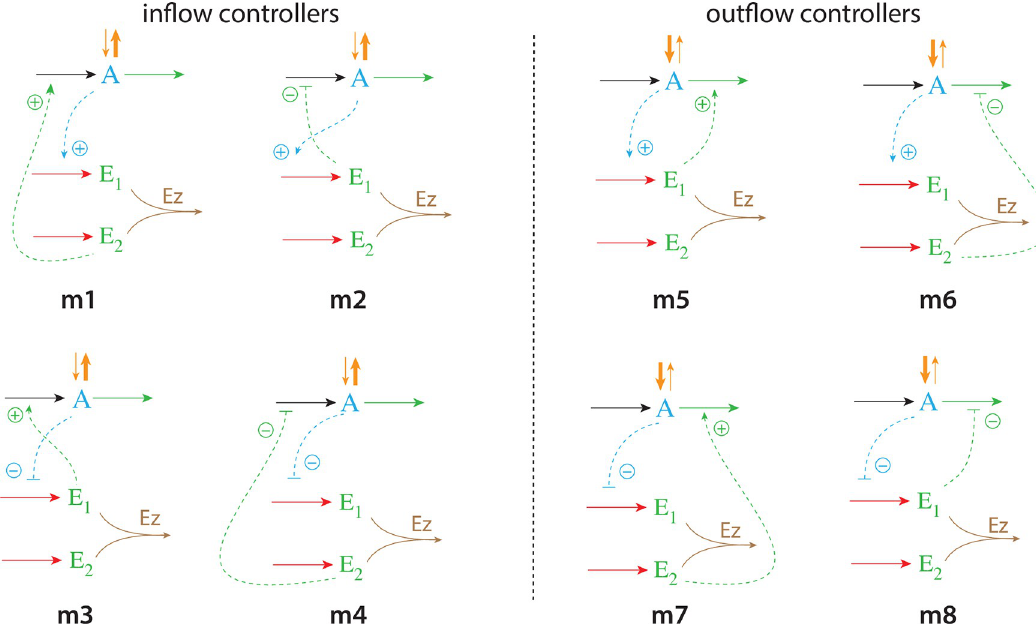
Fig 3. Dual-E (antithetic) integral control in combination with the eight negative feedback structures m1-m8. In the calculations the removal of E 1 and E 2 is catalyzed by enzyme Ez using different mechanisms. The signaling between A and the manipulated variables E 1 / E 2 occurs either by an “inner loop” between A and E 1 (motifs m2, m3, m5, and m8), or by an “outer-loop” signaling between A and E 2 (motifs m1, m4, m6, and m7).